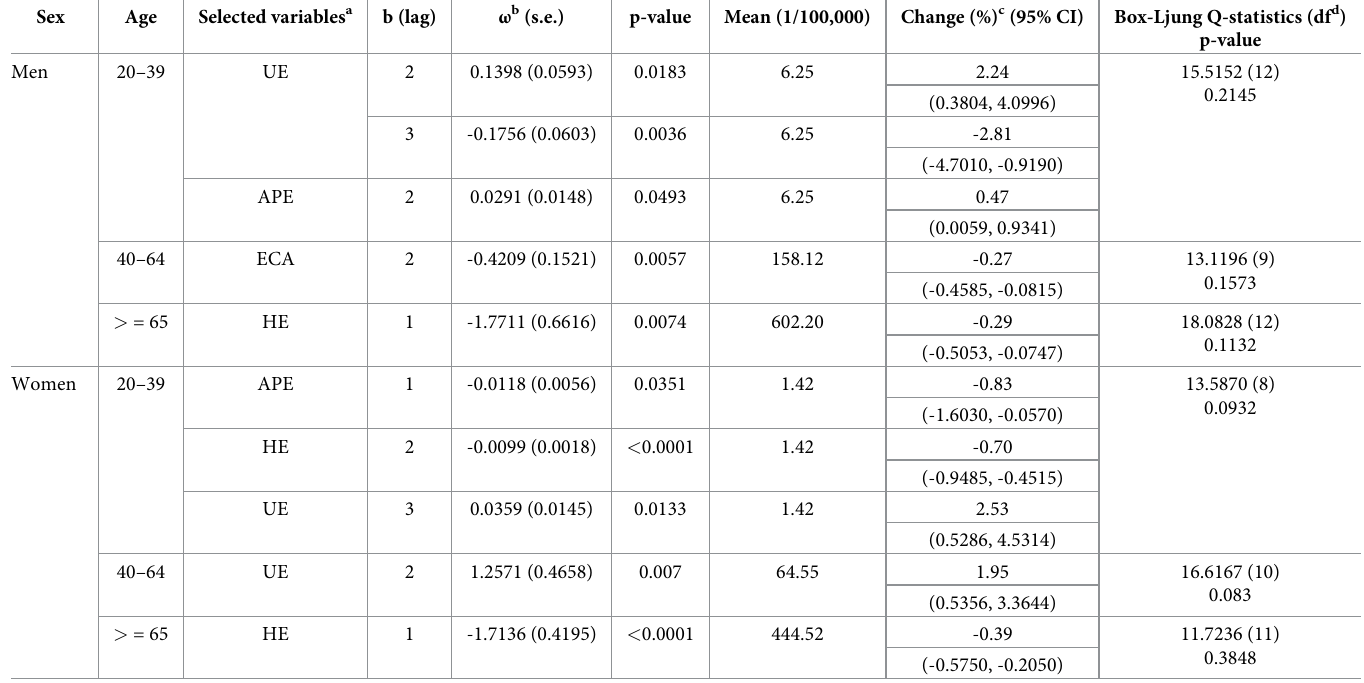
Table 3. Effects of socioeconomic factors on incidence rates of hospitalization due to ischemic heart diseases in Taiwan. Sex Age Selected variables